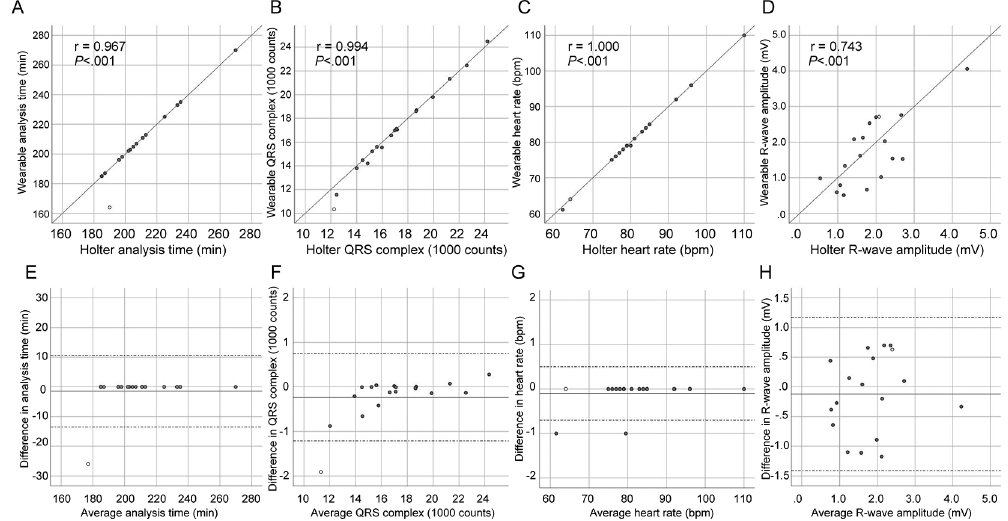
Figure 3. Correlation and Bland-Altman analysis between wearable and Holter ECGs. The scatterplot diagrams (A – D) illustrate correlation analysis with Pearson ’ s coefficient (r) and P values. The Bland-Altman plots (E – H) show a bias (solid line) with 95% limits of agreement (dotted line). Each dot represents paired values derived from all patients. An open circle indicates a patient with skin-electrode contact failure. ECG, electrocardiogram.